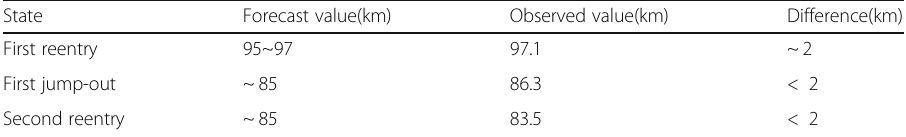
Table 9 Comparisons of complete communication blackout between predictions and the flight observations State Forecast value(km) Observed value(km)